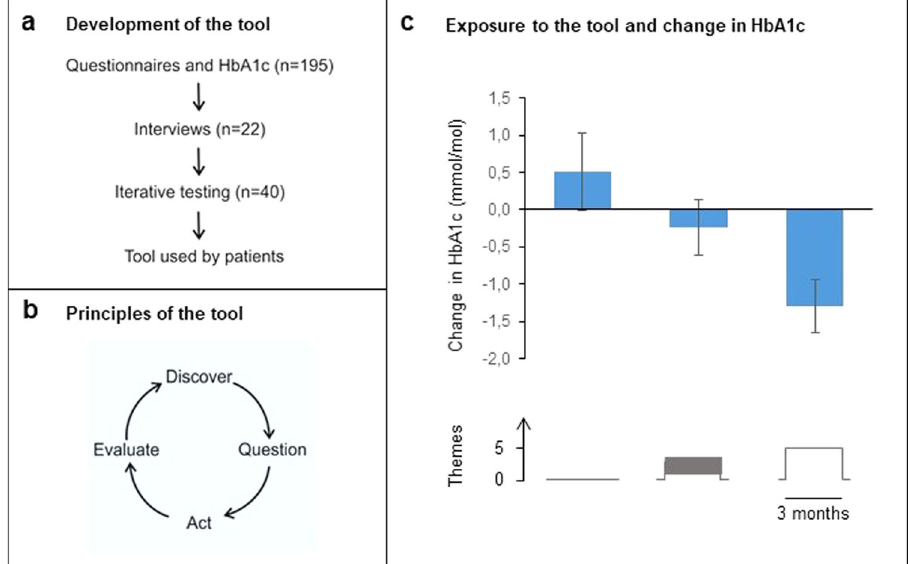
Fig. 1 Outline of the intervention tool. Development ( a ), principles ( b ) and effect of exposure to the tool ( c ). a shows the step-wise development of the tool, commencing with longitudinal analyses of psychological factors associated with HbA1c progression in 195 patients with T2D. This was followed by semi-structured interviews on unmet needs in lifestyle management and expectations of a digital lifestyle tool. The tool underwent repeated testing and modi fi cation based on feedback from patients and healthcare professionals on content, language, usability, and relevance. b depicts the underlying principles. At each login, participants can choose one of 80 different themes to discover new knowledge and methods. A theme consists of tests to explore current habits, texts with health information and exercises to learn behavior change techniques. At the end of each theme, participants ask a question to themselves on how to act on the content. When returning, they evaluate their activities in daily life and proceed to discover another theme. Users can re fi ne earlier questions or ask new ones, in order to stimulate increased knowledge and self-re fl ection as they proceed through the tool. c shows the exposure-response relationship. Participants attended quarterly visits during the fi rst year. Exposure to the tool (number of completed themes) and the corresponding change of HbA1c relative to previous visit for each quarterly period during the fi rst year was determined in all participants who used the tool ( n = 205). A total of 161 participants used the tool as recommended (biweekly) during at least one quarter. Mean values are shown across all individuals for quarterly periods in which no themes ( n = 114 periods), 1 – 4 themes ( n = 228) and at least 5 themes ( n = 311), respectively, were completed. Error bars are